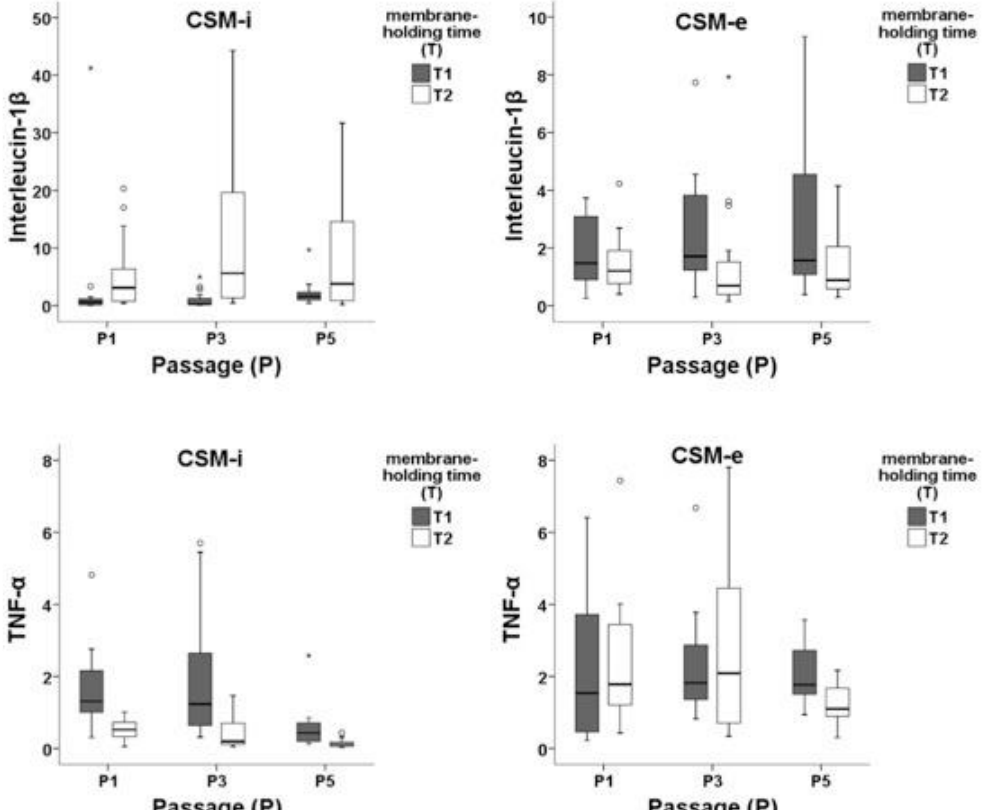
Figure 6. Expression patterns of IL-1 β and TNF- α within in vitro (CMS-i) and in vivo (CMS-e) membranes subdivided by cell passage 1 (P1), 3 (P3), and 5 (P5) and membrane-holding time 5 h (T1) and two weeks (T2). Outliers are marked separately with *.